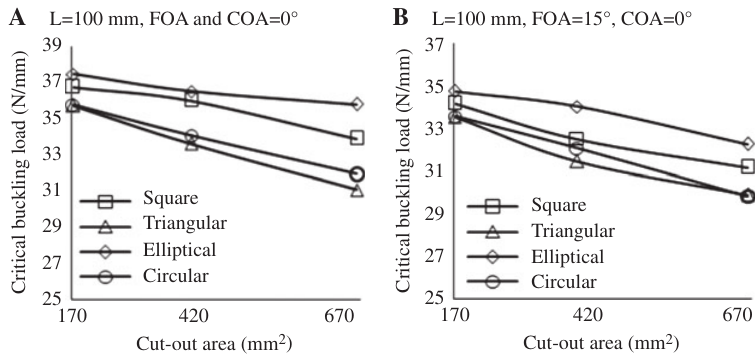
Figure 10 The e ffect of COA on critical buckling load of the composite plates: (A) FOA = 0 ° , L = 100 mm; (B) FOA = 15 ° , L = 100